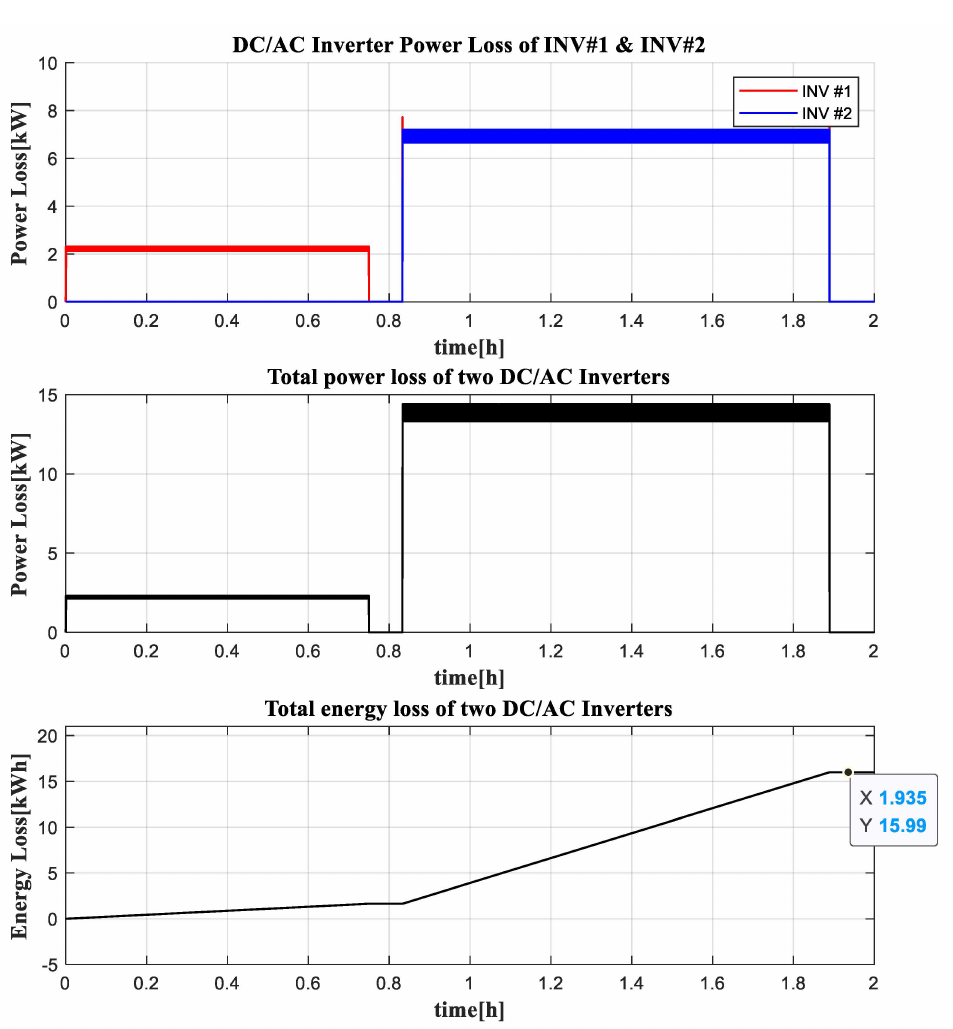
Figure 24. Simulation results for the power and energy loss of 500 kW DC/AC inverter #1,